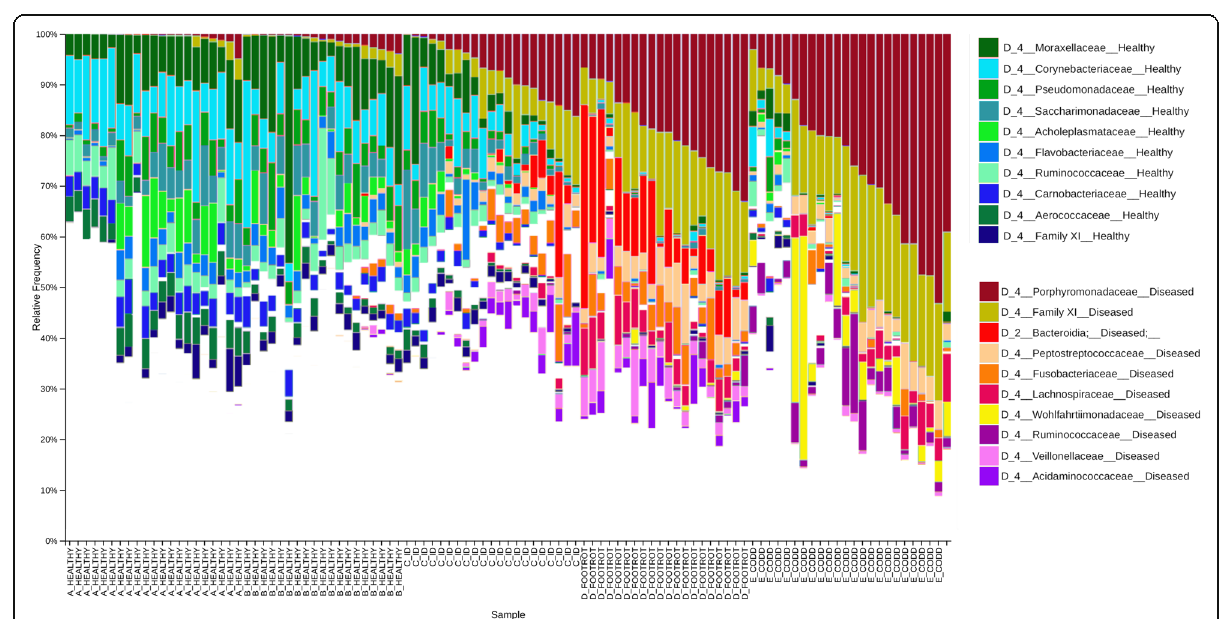
Fig. 6 A taxa plot showing relative abundance of the 10 most abundant bacterial families (identified from the Healthy and Diseased ASV groups) in the microbiomes of the different diseased states (A_Healthy, B_Healthy, C_ID, D_Footrot and